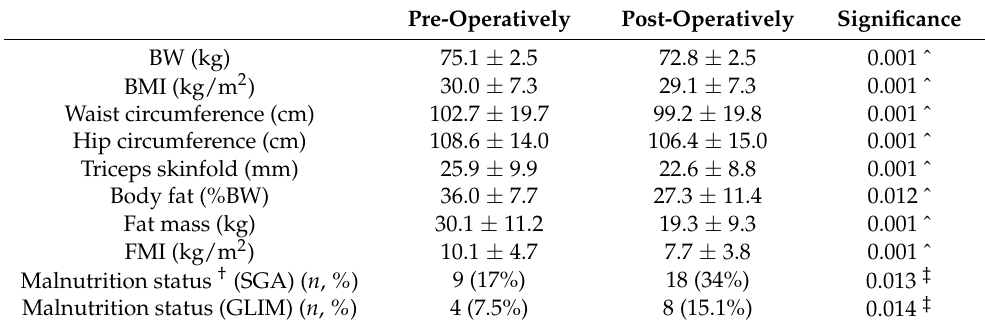
Table 2. Anthropometric characteristics of participants pre- and post-operatively (N = 53).